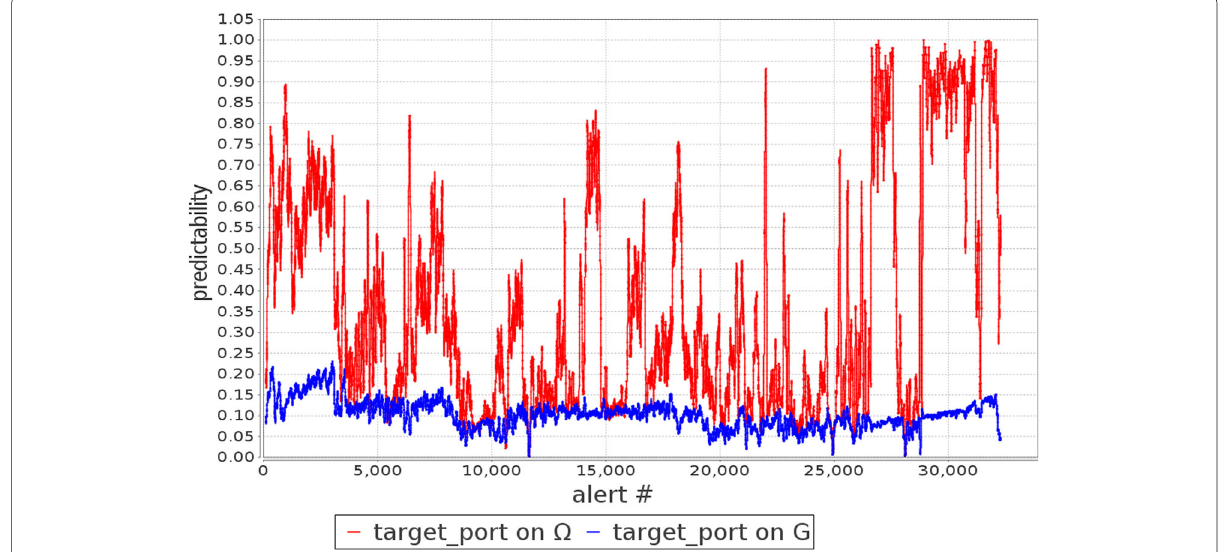
Fig. 7 The ˜ p n ((cid:2)) and ˜ p n ( G ) for target port as the alerts come into the